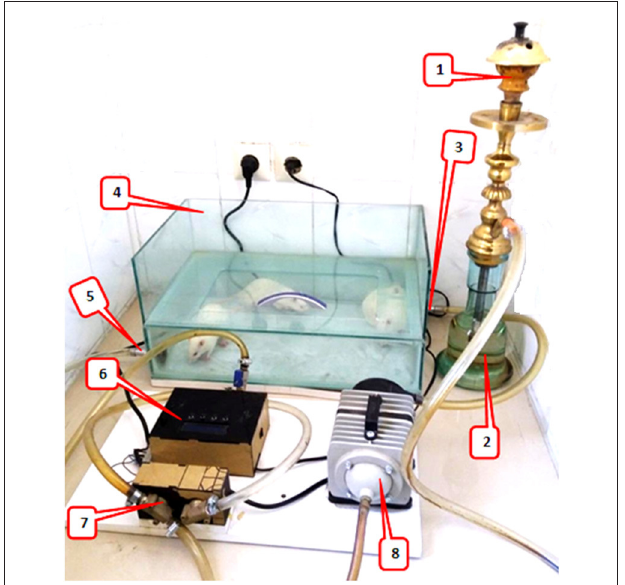
FIGURE 1 | Waterpipe tobacco smoking setup: 1. the ceramic head of hookah for tobacco and charcoal, 2. water jar where the smoke passes, 3. fresh air/waterpipe smoke input, 4. a Plexiglass chamber (8mm thick), placement for animals to inhale hookah smoke, 5. fresh air/waterpipe